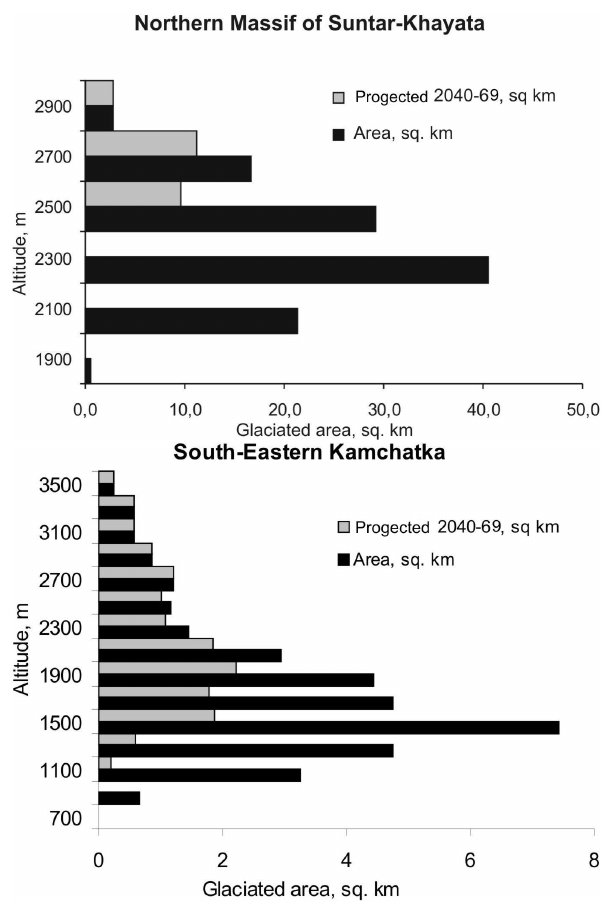
Fig. 2. Examples of hypsographic curves – distribution of ice area versus altitude for the northeast Siberia glaciers system (a) , Kam- chatka (b)